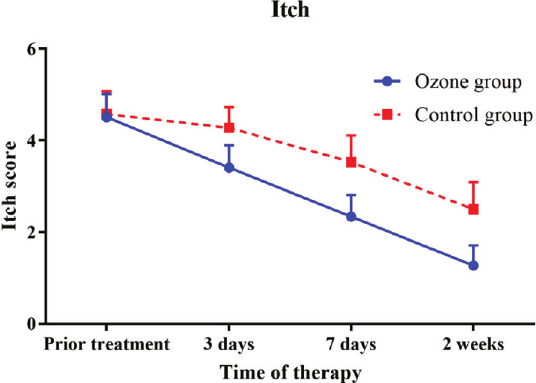
Figure 3. Contour plots of itch scores of the two groups at different